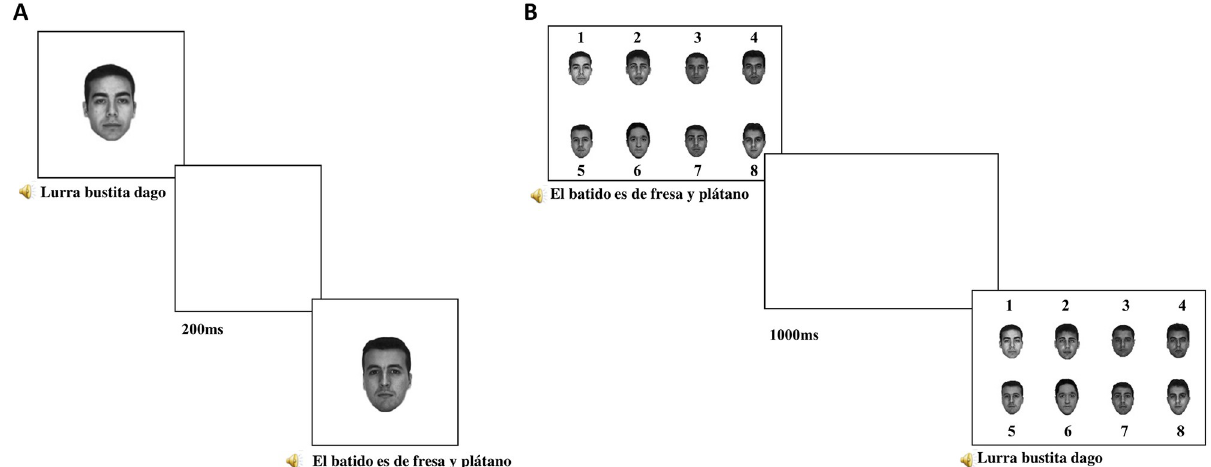
Fig 1. The procedure of the memory confusion paradigm. This diagram shows the two main phases of the paradigm. On Panel A, the encoding phase, where faces were presented with the audio sentences. On panel B, the final recognition phase. Grayscale photos of eight Caucasian males with neutral expressions were selected from the free AR face database